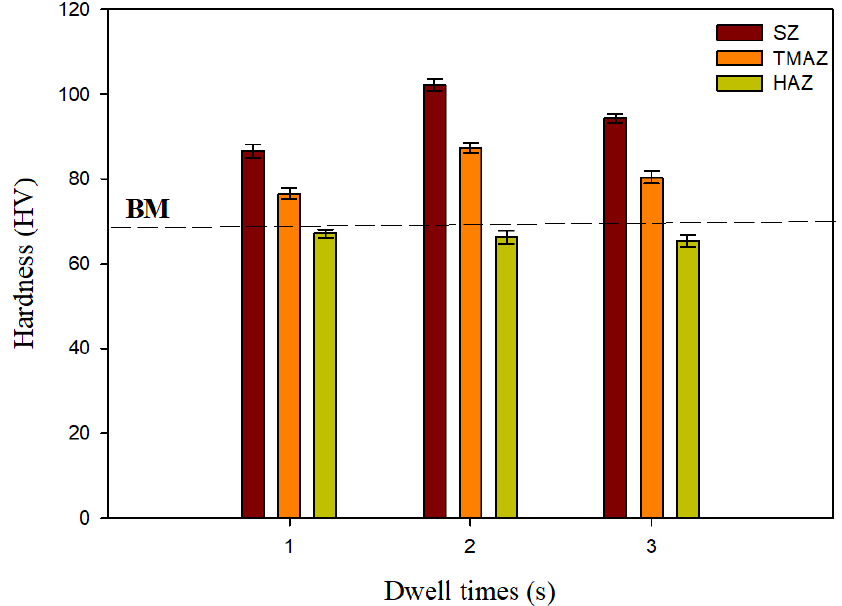
Figure 8. Average hardness in the weld zones (HAZ, TMAZ, and SZ) of the FSSWed AA5052-H32 lap joints achieved at various dwell times (1–3 s) and 500 rpm tool rotation speed. joints achieved at various dwell times (1–3 s) and 500 rpm tool rotation